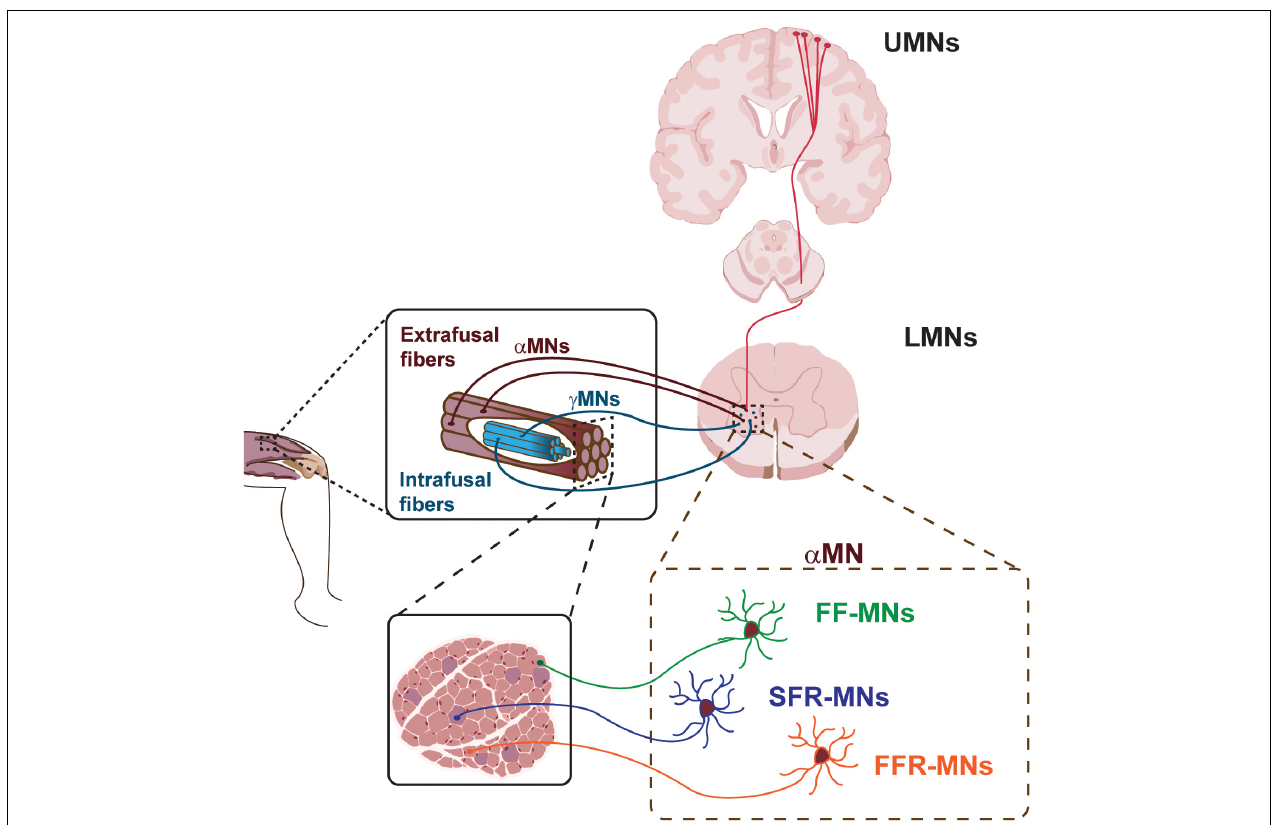
FIGURE 1 | Schematic of the motor system. Upper motor neurons (UMNs) project to lower motor neurons (LMNs) in the brainstem and spinal cord. LMNs innervate skeletal muscle fibers. Different classes of α -MNs innervate diverse skeletal muscle fibers. FF-MNs, fast-fatigable MNs. SFR-MNs, slow fatigue resistant MNs. FFR-MNs, fast fatigue resistant